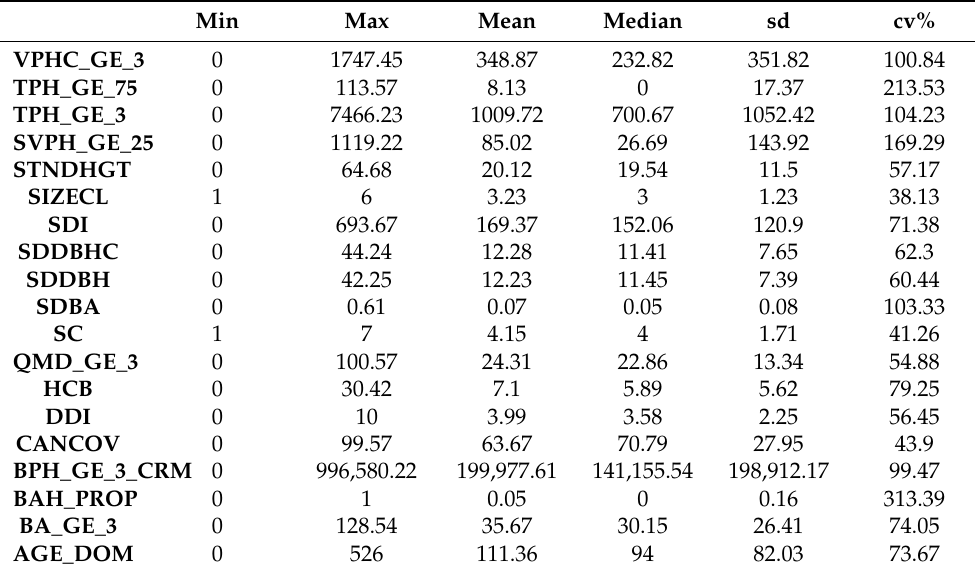
Table 2. Summary of field measurement derived forest